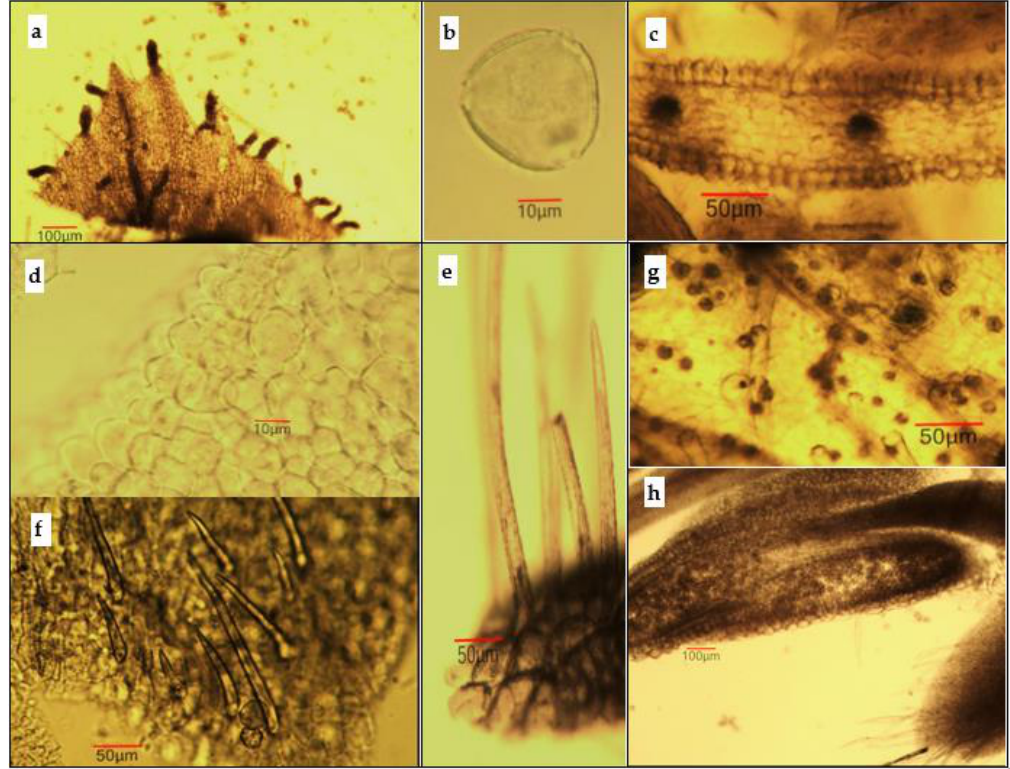
Figure 5. Microphotos of powdered flower and flower bud samples of Koelreuteria paniculata: ( a ) fragment of corolla and pollen grains; ( b ) pollen grain; ( c ) fragment of the corolla in cross section; ( d ) papillose epidermal cells of the corolla in surface view; ( e ) fragment of calyx with unicellular- covering trichomes with surface inlays; ( f ) fragment of calyx with covering trichomes; ( g ) fragment of calyx with oxalate druses; ( h ) fragment of the flower bud with anther and parts of perianthium.